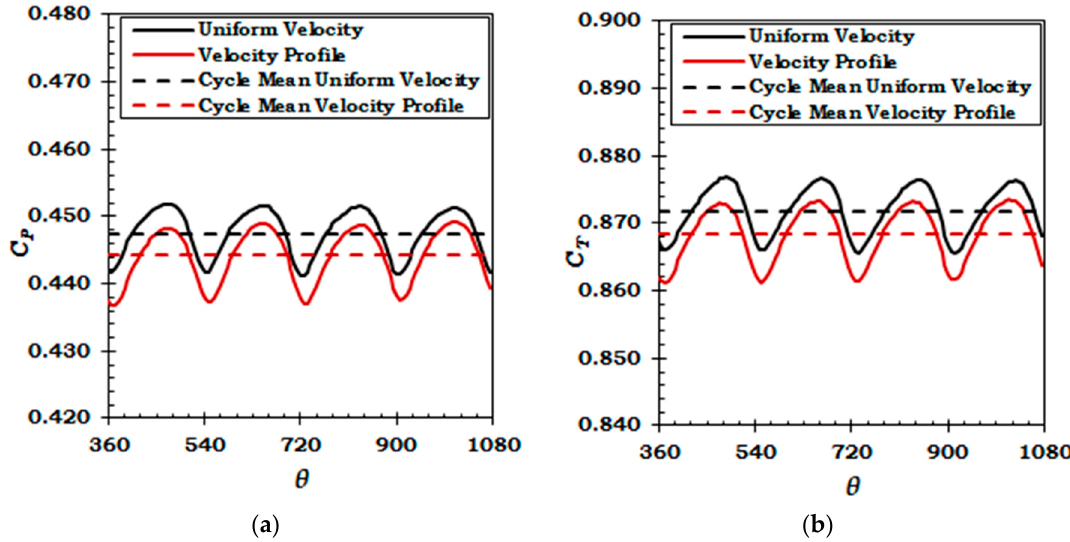
Figure 6. Rotor ( a ) power coefficient; ( b ) thrust coefficient.